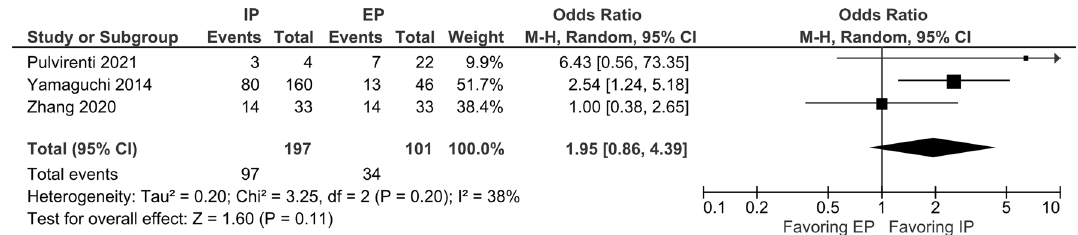
Fig. 3 Odds ratio of ORR using EP as reference. Three studies that directly compared the ORRs of IP and EP were included in this analysis. Odds ratios were calculated using EP as a reference. Among them, one was a randomized phase II trial (5) and the other two were retrospec- tive studies (6, 23). EP platinum plus etoposide, IP platinum plus irinotecan, ORR overall response